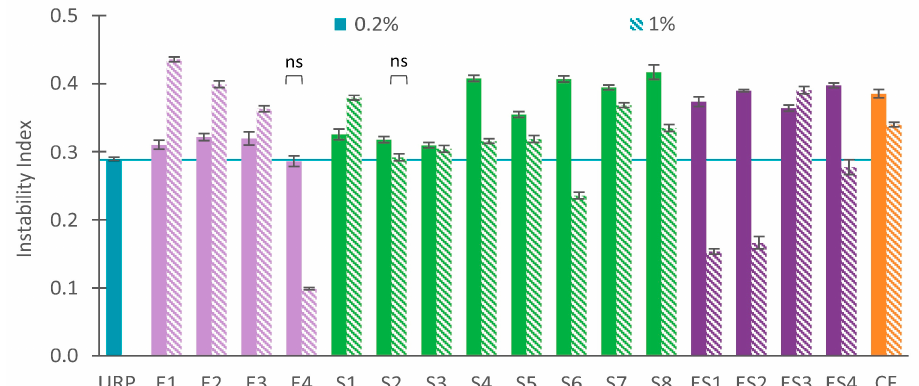
Figure 3. Instability index of URP with 0.2 or 1% of dispersing agents (6 h at 300 × g ). Refer to Tables 1–4 for dispersing agent labels. Error bars depict sampling error. Values are significantly different from the control URP ( p < 0.001) except for nonsignificant results (ns).